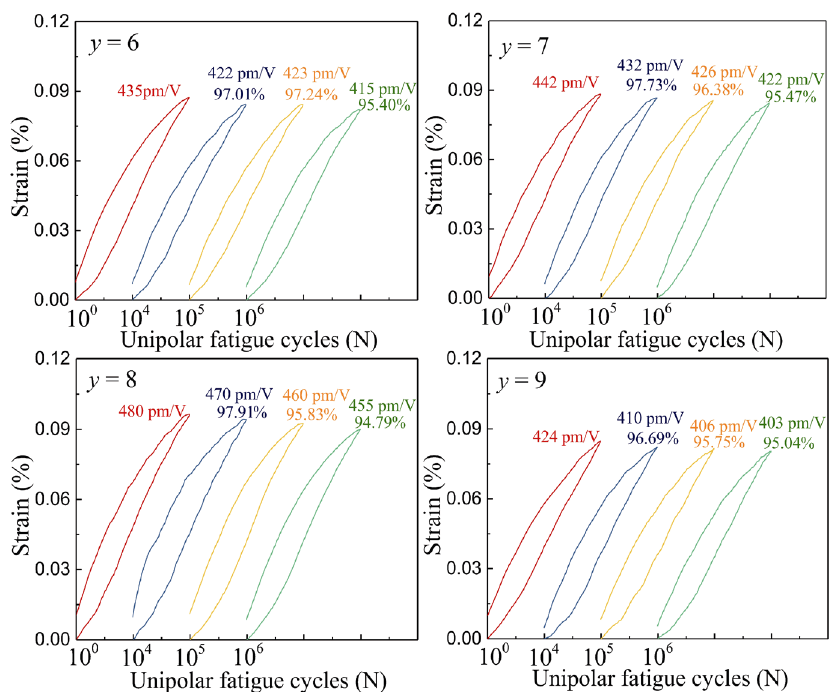
Fig. 8 Unipolar S – E curves of the poled KNNT–0.055BZ + 0.03Zr + y Mn ceramics before and after 10 4 , 10 5 , and 10 6 unipolar fatigue